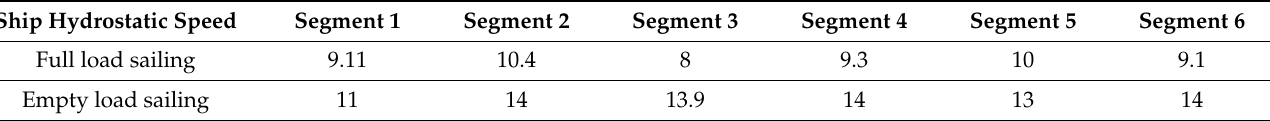
Table 5. Sailing plan of the ship in one whole navigation.